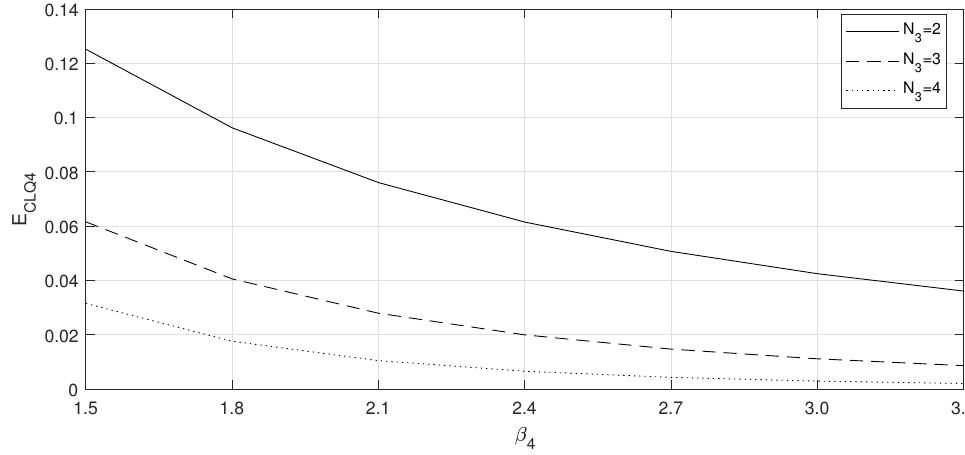
Figure 10. Expected customer loss in Queue-4 on β 4 vs. N 3